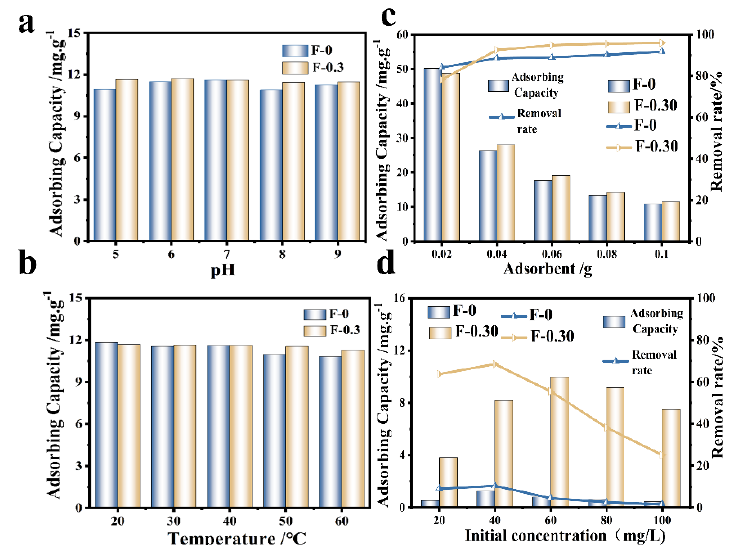
Figure 5. ( a ) The variation of Cr (VI) adsorption by an adsorbent at different pH. Reaction condi- tions: Cr (VI) (40 mg/L, 30 mL), adsorbent (0.1 g), and temperature (20 °C). ( b ) The variation of Cr (VI) adsorption by adsorbent at different temperatures. Reaction conditions: Cr (VI) (40 mg/L, 30 mL), adsorbent (0.1 g), and pH (No adjustment). ( c ) The adsorption results of Cr (VI) by adding adsorbent. Reaction conditions: Cr (VI) (40 mg/L, 30 mL), pH (not adjustable), and temperature (20 °C). ( d ) The effect of initial concentration on the removal rate and adsorption capacity of RhB. Reaction conditions: 30.0 mL. Reaction time: 60